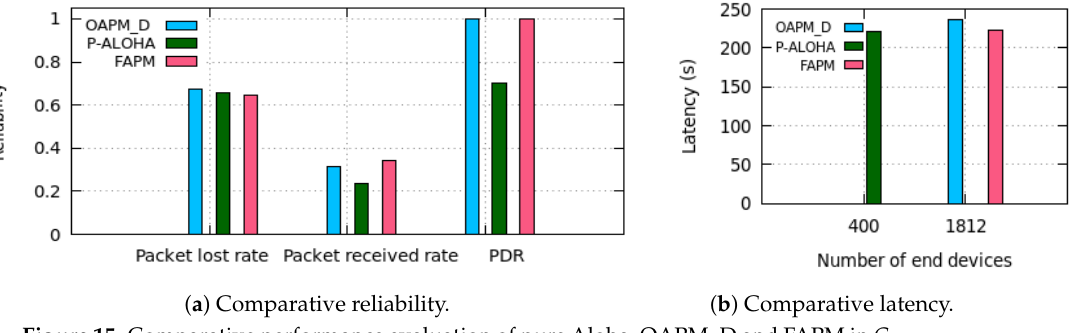
Figure 15. Comparative performance evaluation of pure Aloha, OAPM_D and FAPM in C 16,16,16,16,16,16